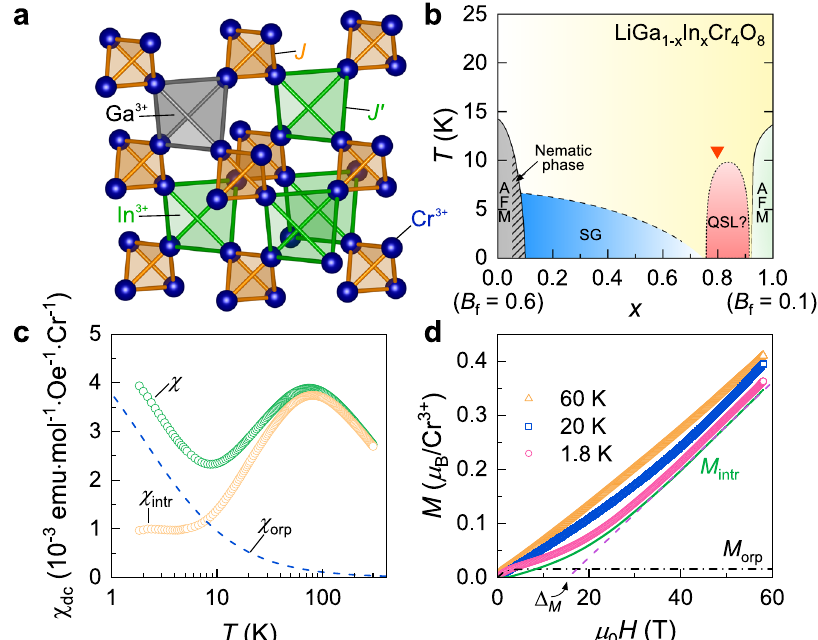
Fig. 1 Crystal structure, phase diagram, and magnetic properties. a Schematic structure of the bond-disordered breathing pyrochlore LiGa 0.2 In 0.8 Cr 4 O 8 . b T - x phase diagram of LiGa 1 − x In x Cr 4 O 8 . The inverse red triangle marks the investigated x = 0.8. c Temperature dependence of the static magnetic susceptibility χ dc ( T ) and its decomposition into the intrinsic χ intr ( T ) and the orphan spin contribution χ orp ( T ). d High- fi eld magnetization at selected temperatures. The black dash-dotted and green dashed lines indicate the orphan spin magnetization M orp ( T ) and the bulk magnetization M intr ( T ), respectively. A linear extrapolation gives the spin pseudogap of Δ M / k B ~ 20